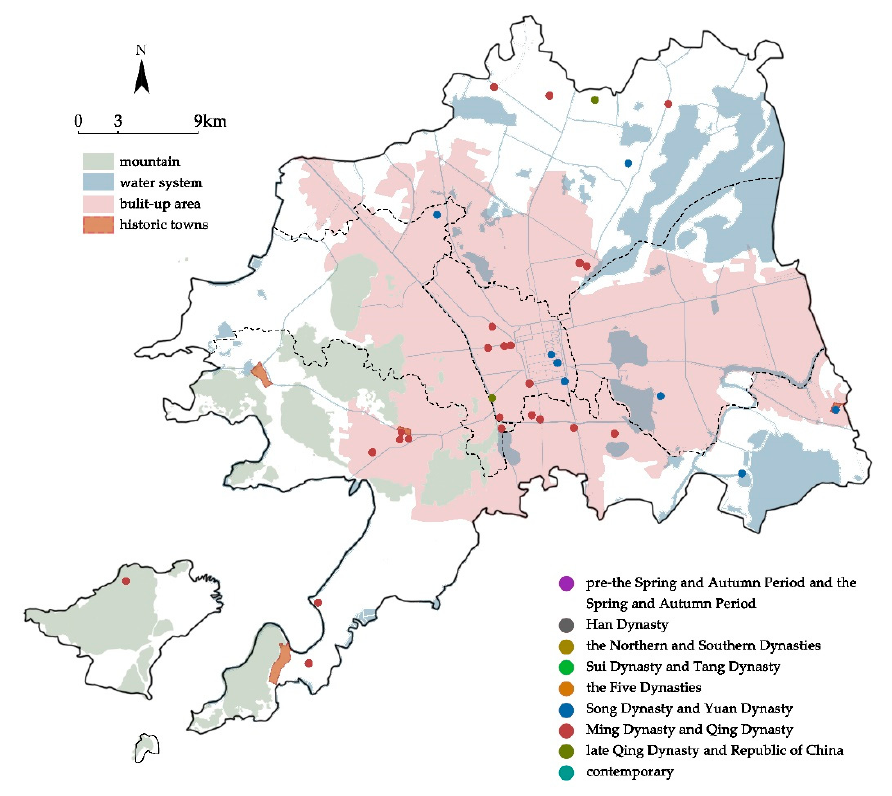
Figure 6. Distribution of bridges in Suzhou.